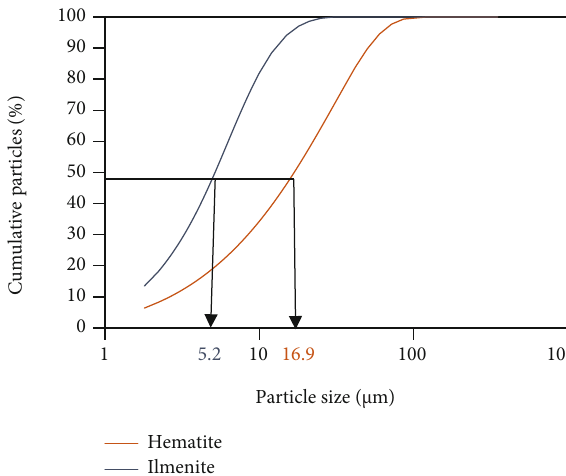
Figure 2: Particle size distribution (PSD) for hematite and ilmenite.